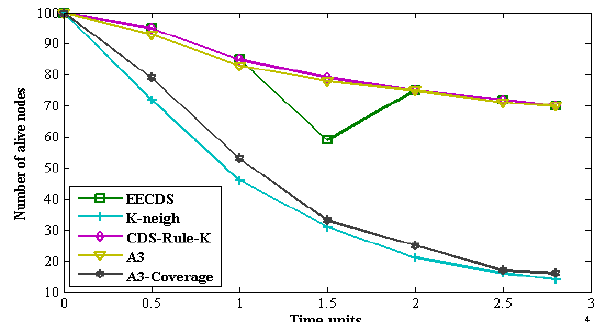
Figure 3. Network lifetime for number of active nodes